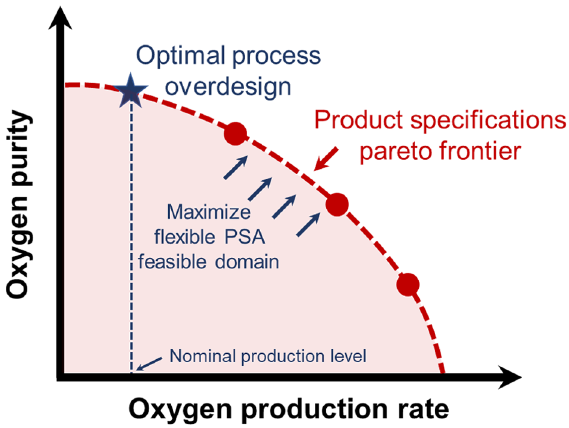
Figure 2. An illustrative depiction of product specifications Pareto frontier and feasible domain for pressure swing adsorption (PSA)-based flexible MOC operation. The key objective is to push the Pareto frontier and maximize the feasible PSA operation area using the simulation-based optimization framework.